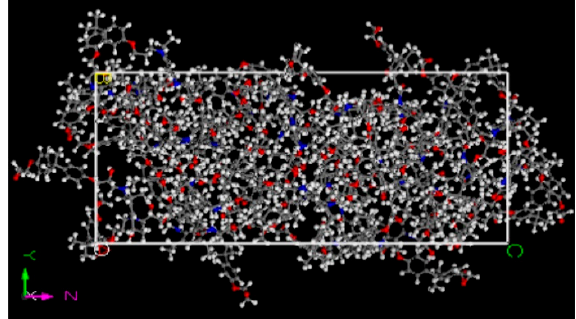
Figure 4. Model for cross-linked epoxy resin (EP).